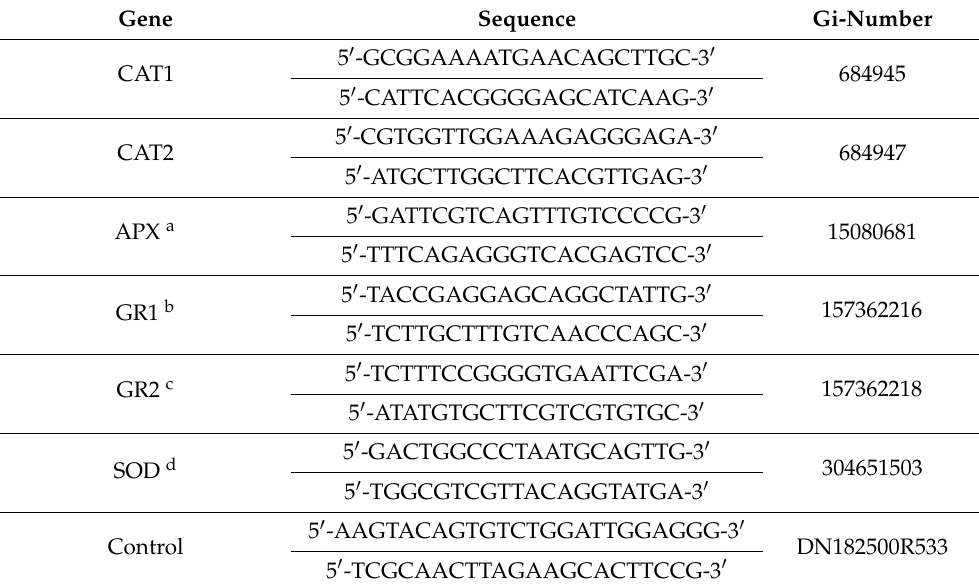
a, peroxisome type APX; b, chloroplastic glutathione reductas; c, cytosolic glutathione reductase; d, chloroplast copper/zinc superoxide